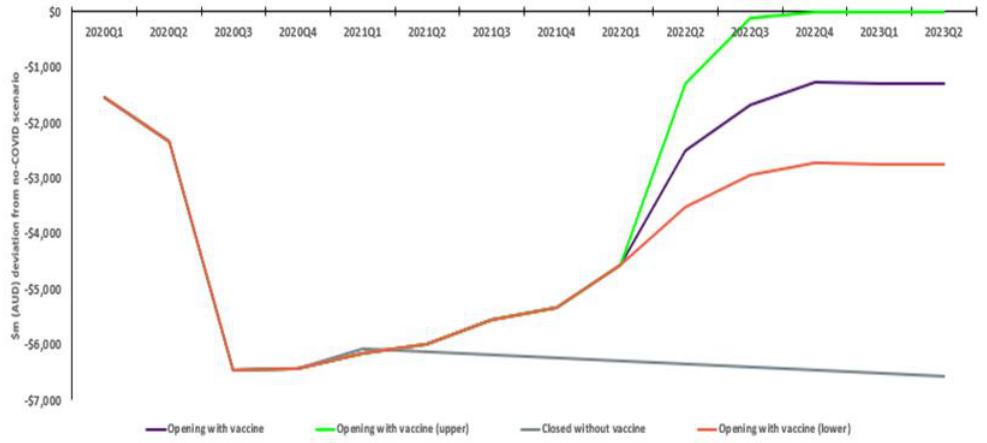
Figure 3. Real education exports: Estimated deviation from no COVID scenario (%). Figure 3. Real education exports: Estimated deviation from no COVID scenario (AUD bn).